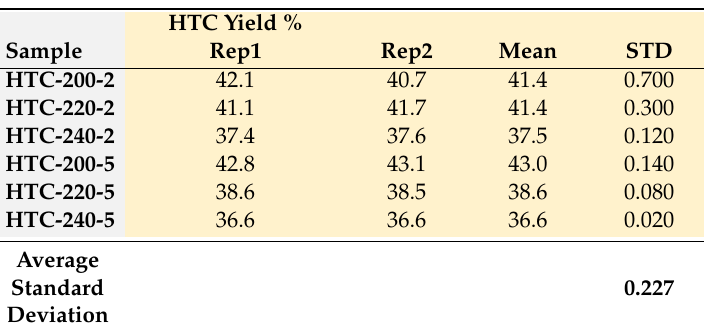
Table A1. Statistical analysis of the HTC